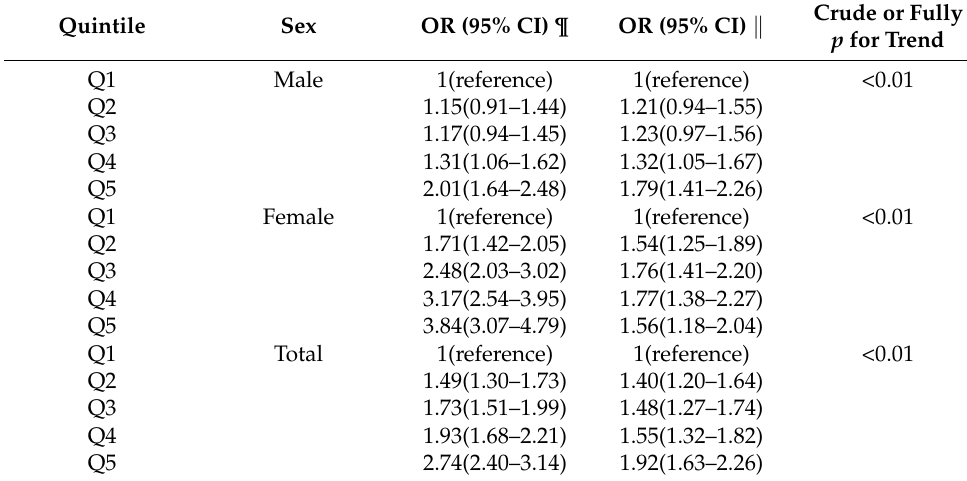
Table 3. Odds ratios for hypertension on quintiles of SUA levels.